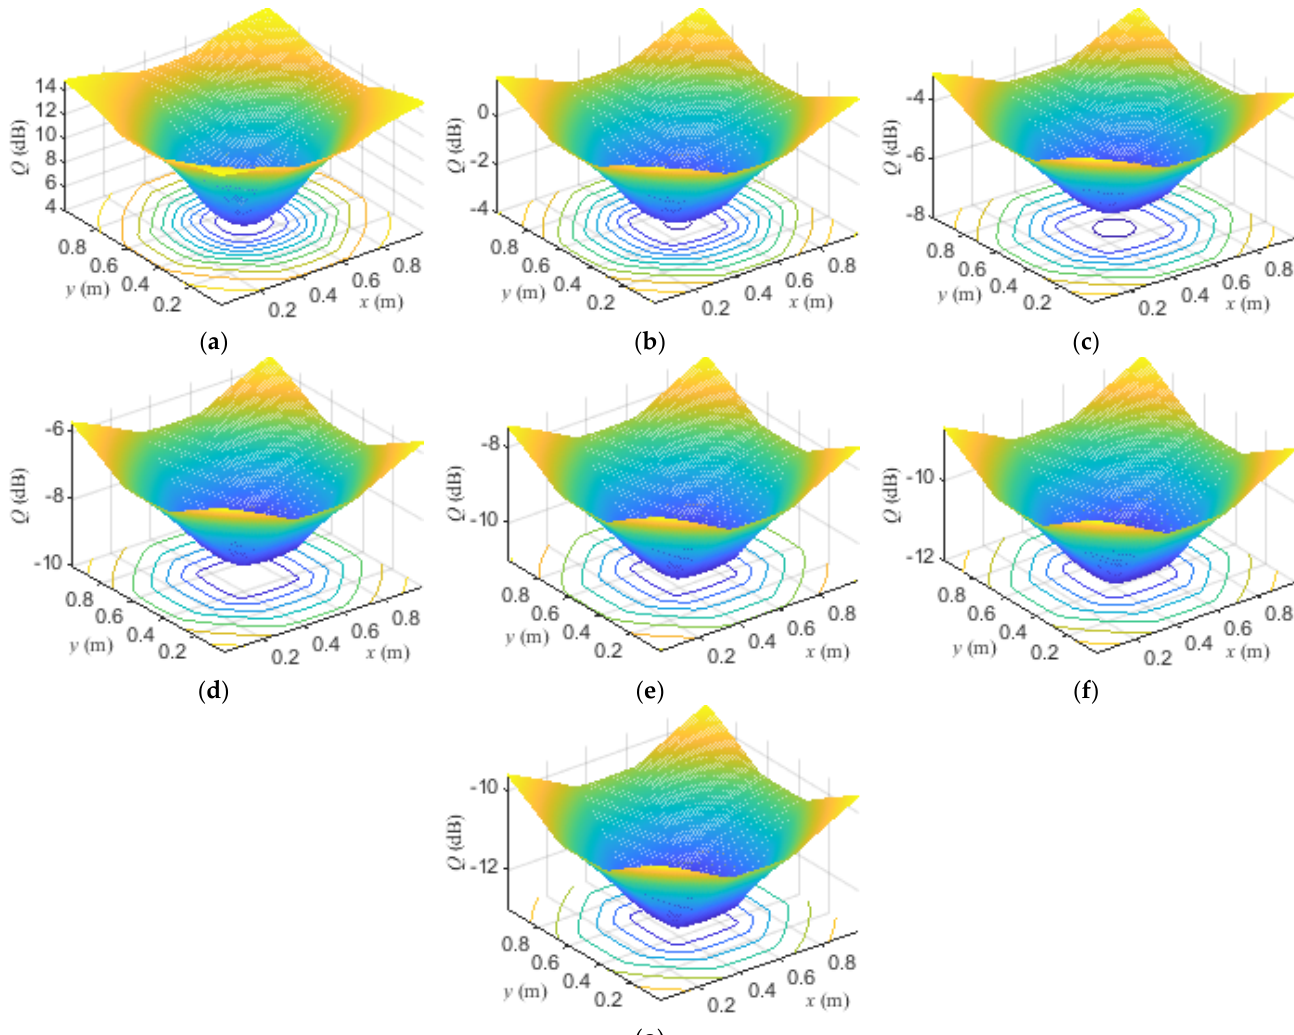
Figure 11. Calculation results of the relationship between the Q and LED position in a room size of 1 m × 1 m: ( a ) θ 1/2 = 10°; ( b ) θ 1/2 = 20°; ( c ) θ 1/2 = 30°; ( d ) θ 1/2 = 40°; ( e ) θ 1/2 = 50°; ( f ) θ 1/2 = 60°; ( g ) θ 1/2 = 70°.